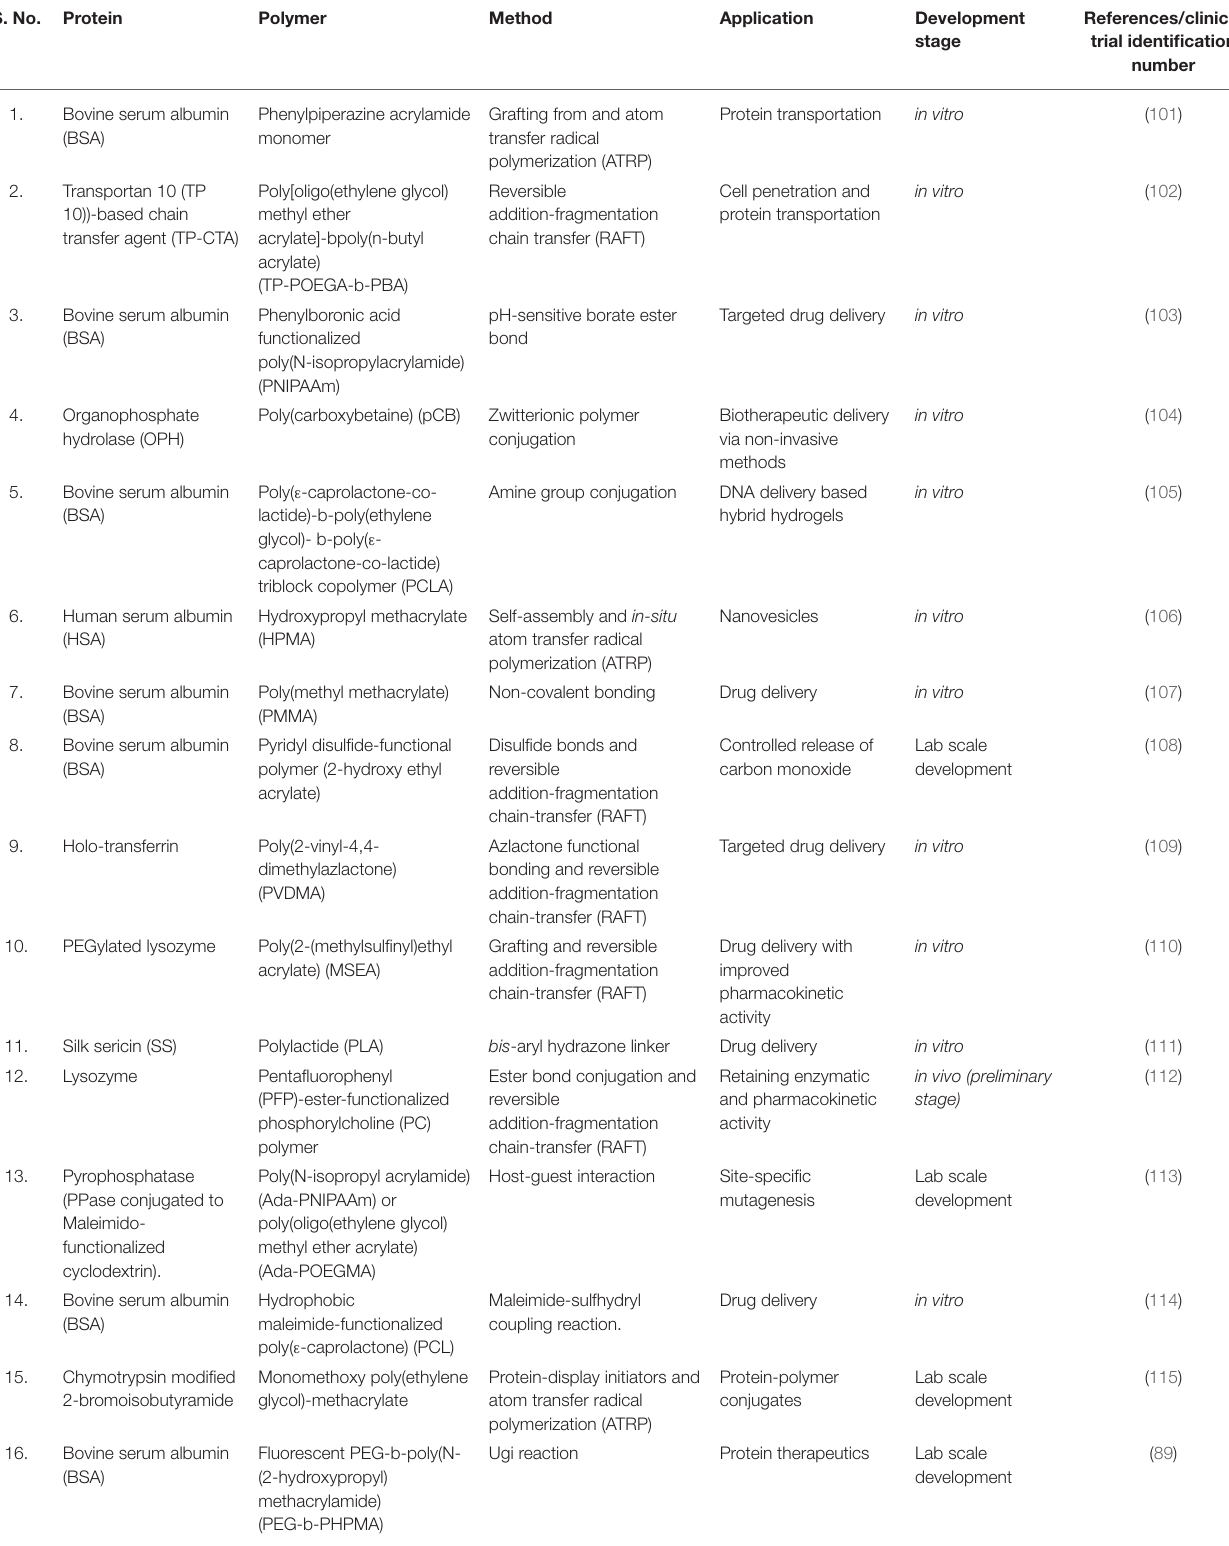
TABLE 2 | List of protein-polymer conjugates for various biomedical applications. S. No.